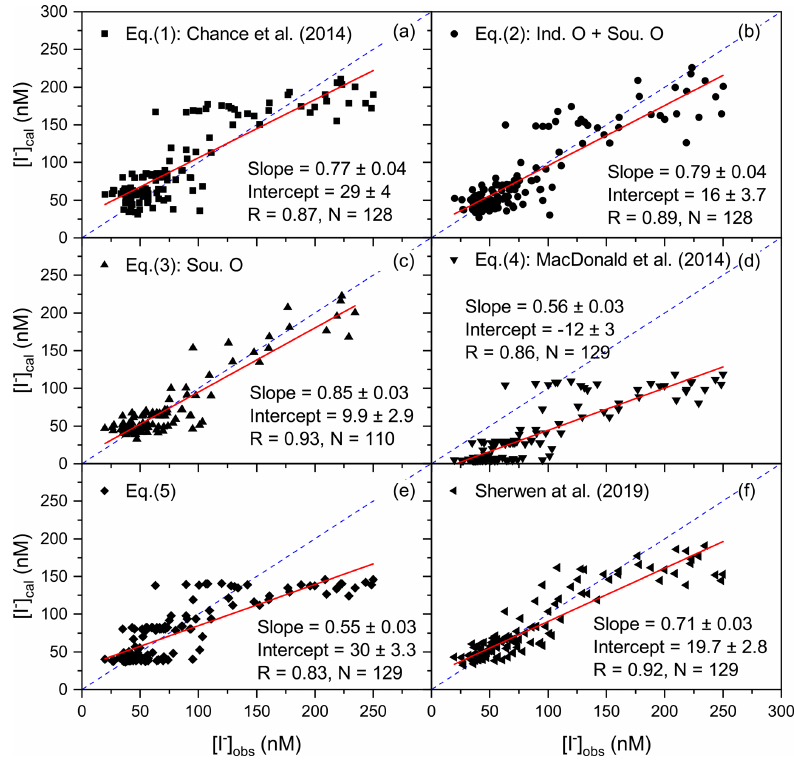
Figure 6. Linear fit analysis of estimated sea surface iodide (SSI) concentrations ( y axis) from parameterisation methods in Eqs. (1) to (5) and model prediction (Sherwen et al., 2019) against measured SSI concentration ( x axis) from ISOE-9, SK-333, and BoBBLE. (c) SSI values are compared only with ISOE-9 observations for the Southern Ocean parameterisation. R represents the Pearson’s correlation coefficient, and N is the size of the dataset. The dashed blue line represents the identity (1 : 1)